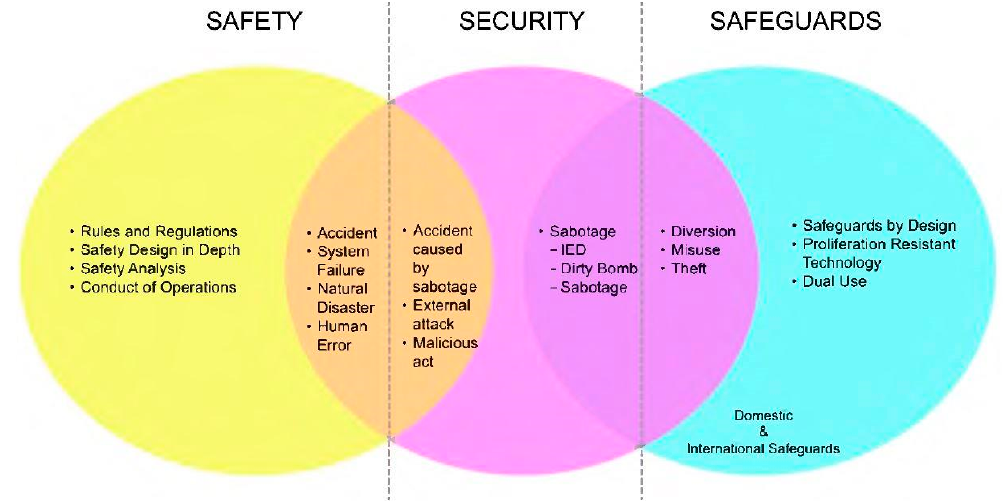
Figure 3. The “3S Concept” for harmonizing Safety, Security and Safeguards (IED: Improvised Explosive Device, Dual Use: technology designed or suitable for both civilian and military purposes). Source: SNL adaptation of a graphic by S. DeMuth, Los Alamos National Laboratory (LANL), ASTOR Meeting, Pori, Finland, 2013.